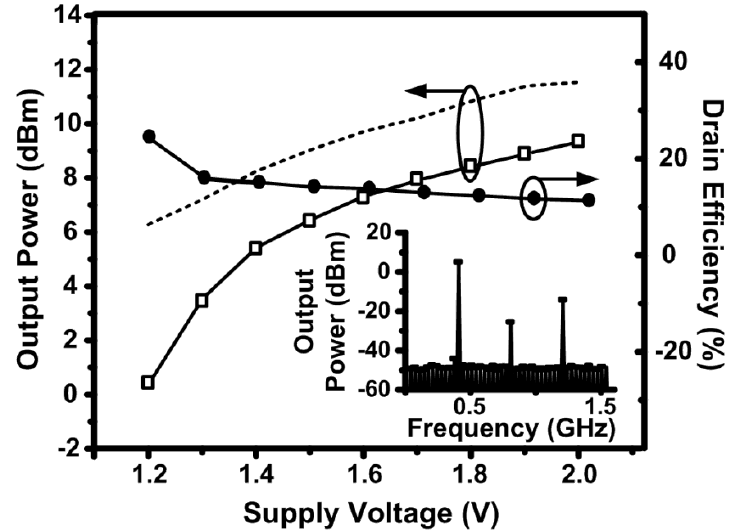
Figure 14. Measured output power and drain efficiency of the 433 MHz design as a function of the supply voltage. The dashed line shows the simulated output power and the inset figure shows the measured spectrum of the output signal at a supply voltage of 1.5